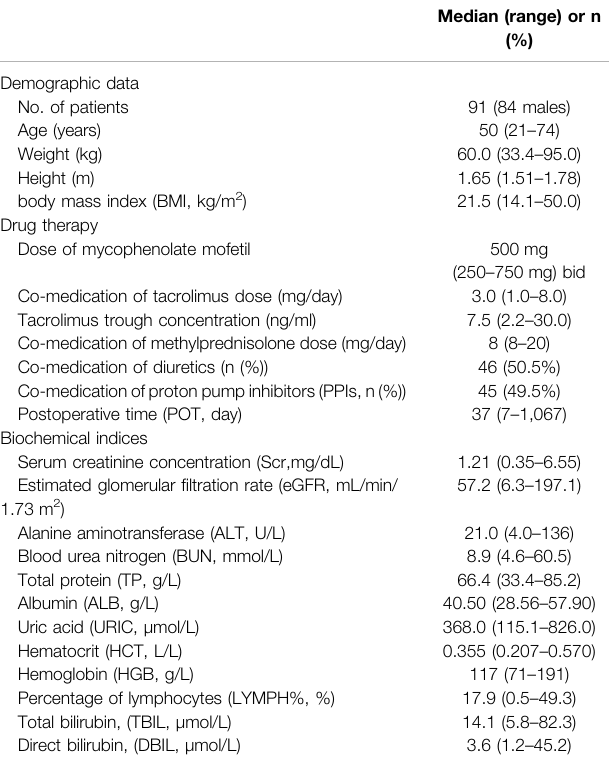
TABLE 1 | Demographic characteristics of adult heart transplant recipients for population pharmacokinetic analysis of mycophenolic acid (MPA).